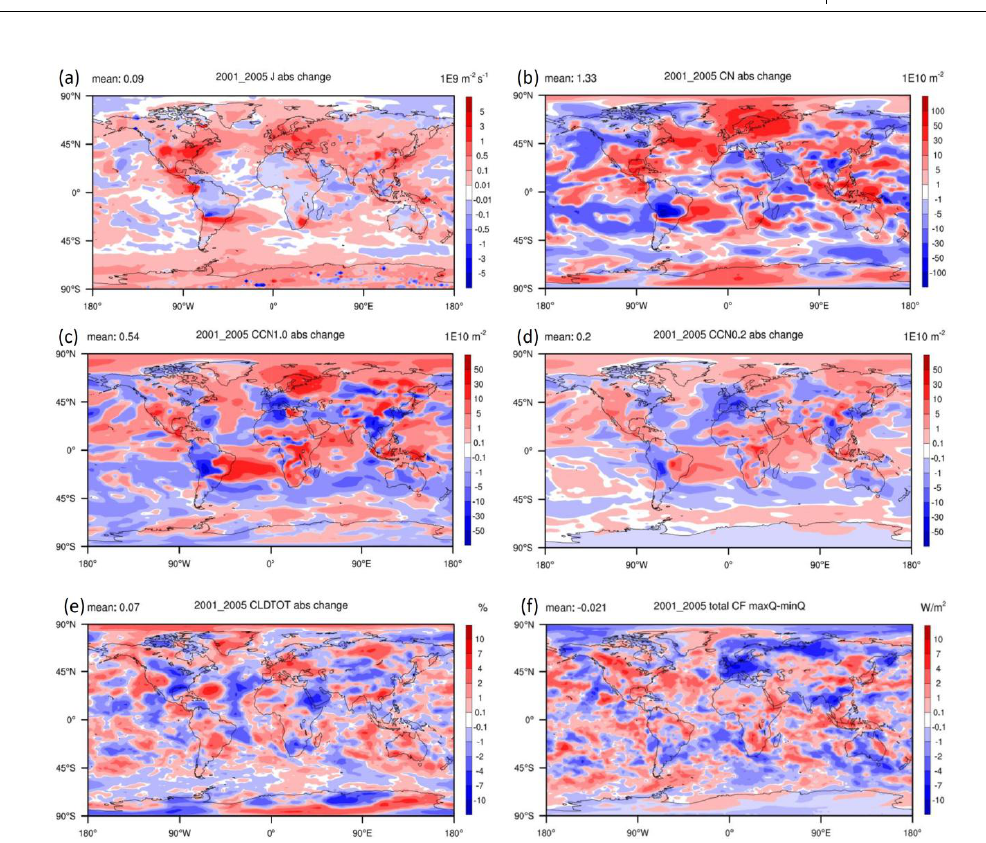
Figure 6. Fig. 6. Horizontal distribution of 5-yr mean differences between max Q and min Q cases (max Q − min Q ) for column integrated (a) J , (b) CN, (c) CCN1.0, and (d) CCN0.2 as well as for (e) total cloud cover and (f) net cloud forcing